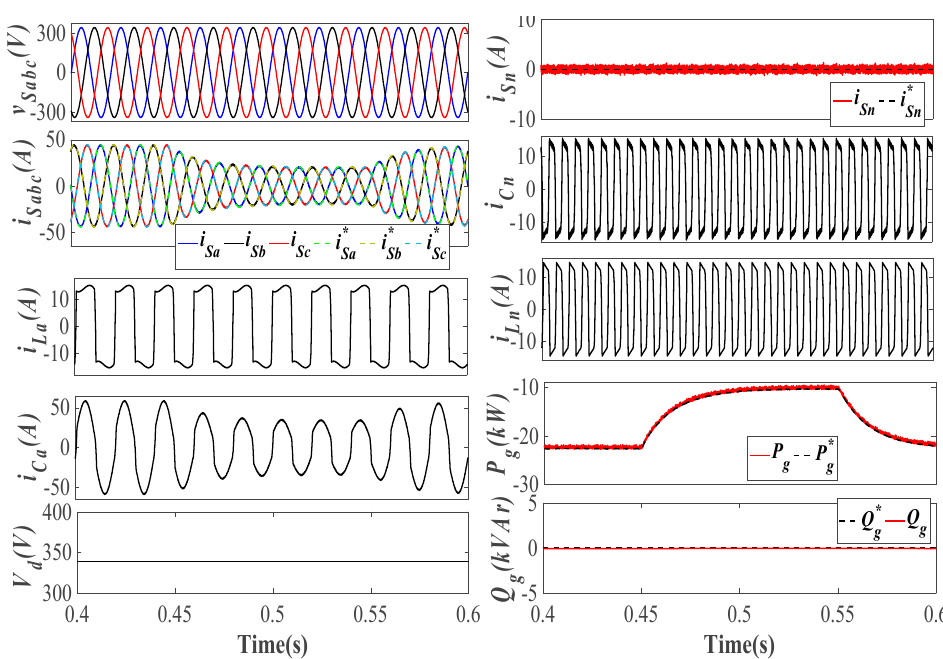
Figure 6. Irradiation variation analysis of v Sabc , i Sabc , i La , i Ca , V d , i Sn , i Cn , i Ln , P g and Q g .